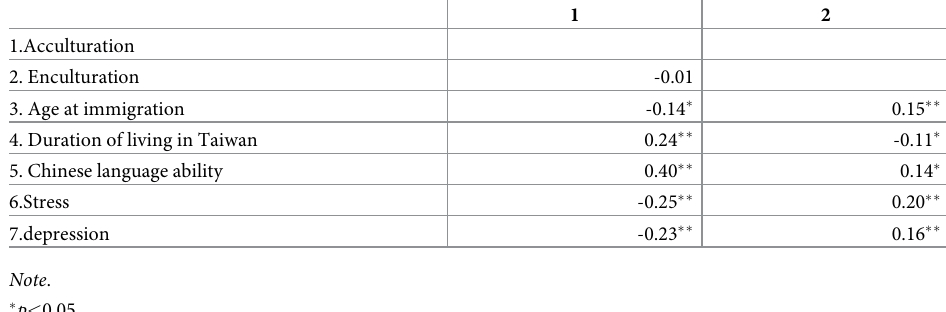
Table 4. Correlations of acculturation, enculturation, and traditional indicators for